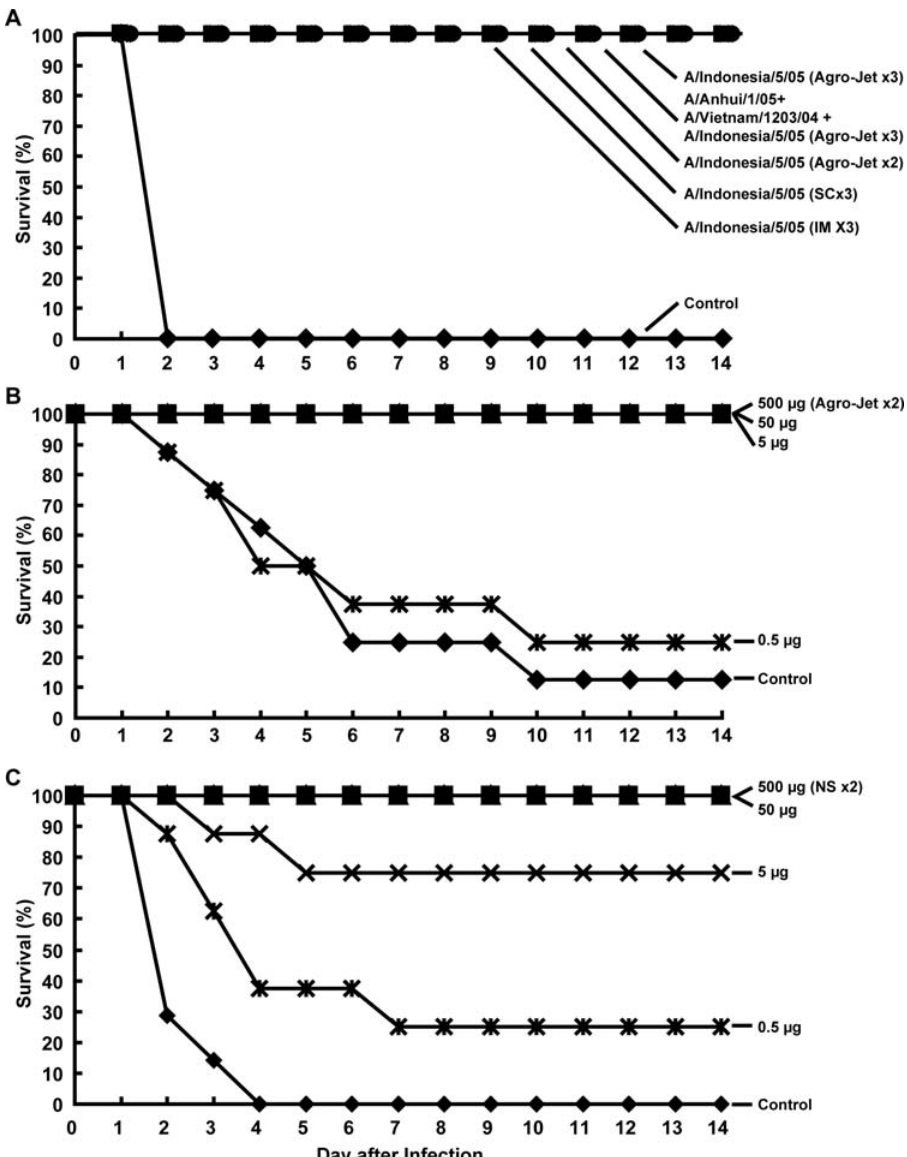
Figure 5. Immune protection after DNA vaccination against lethal challenge with heterologous A/Vietnam/1203/2004 using needle or needle-free injection in chickens and dose-response analysis of efficacy for each route. A. Chickens were immunized with either trivalent HA encoding plasmids: pCMV/R-HA(A/Indonesia/05/2005) plus pCMV/R-HA(A/Anhui/1/2005) plus pCMV/R-HA(A/Vietnam/1203/2004) by Agro-Jet H three times, monovalent plasmid, pCMV/R-HA(A/Indonesia/05/2005) with Agro-Jet H twice or three times, or by needle and syringe subcutaneously or IM three times as indicated. Control animals were injected with a no insert vector by needle and syringe IM three times. A total of 500 m g plasmid DNA was used in each injection for all groups. Controls died 2 days after infection by nasal inoculation. The geometric mean reciprocal endpoint titers (GMT) for hemagglutination inhibition (HI) in each group one week after the last vaccination and two weeks post-challenge respectively were: Control: undetectable, not done; Trivalent by Agro-Jet ( 6 3): 777, 304; A/Indonesia/05/2005 by Agro-Jet ( 6 3): 320, 285; A/Indonesia/ 05/2005 by Agro-Jet ( 6 2): 516, 533; A/Indonesia/05/2005 by needle (subcutaneous 6 3): 211, 155; A/Indonesia/05/2005 by Agro-Jet (intramuscular 6 3): 118, 495. B. Immunization with trivalent DNA vaccine, pCMV/R-HA(A/Anhui/1/2005), pCMV/R-HA(A/Indonesia/05/2005), and pCMV/R-HA(A/ chicken/Nigeria/641/2006), twice by Agro-Jet H intradermally/subcutaneously in different doses (500 m g, 50 m g, 5 m g, and 0.5 m g) as indicated. Controls were immunized with 500 m g empty vector. Controls died 4 days after infection by intranasal inoculation. The GMT HI in each group two weeks post-challenge were: Control: 80 (n=1); Trivalent by Agro-Jet (500 m g): 580 (n=8); Trivalent by Agro-Jet (50 m g): 430 (n=8); Trivalent by Agro- Jet (5 m g): 183 (n=8); Trivalent by Agro-Jet (0.5 m g): 200 (n=2). C. Immunization with trivalent DNA vaccine pCMV/R-HA(A/Anhui/1/2005), pCMV/R- HA(A/Indonesia/05/2005), and HA(A/chicken/Nigeria/641/2006) was performed twice by needle and syringe IM at doses outlined in panel B. The GMT HI in each group two weeks post-challenge were: Control: not done (n=0); Trivalent by needle (500 m g): 325 (n=8); Trivalent by needle (50 m g): 120 (n=8); Trivalent by needle (5 m g): 197 (n=8); Trivalent by needle (0.5 m g): 200 (n=2). The chickens in panel B and C each received two immunizations.